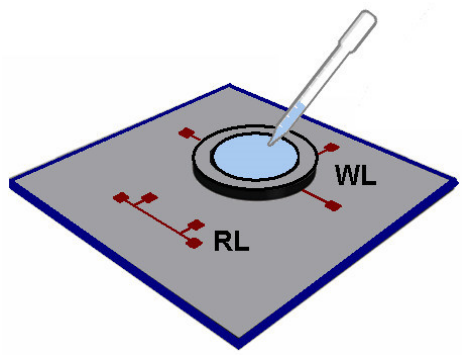
Figure 13. A scheme of the experimental apparatus for the measurement of the thermal conductivity and heat capacity of NFs, where WL and RL represent the working and references line, respectively (adapted from López-Bueno et al. [24]).